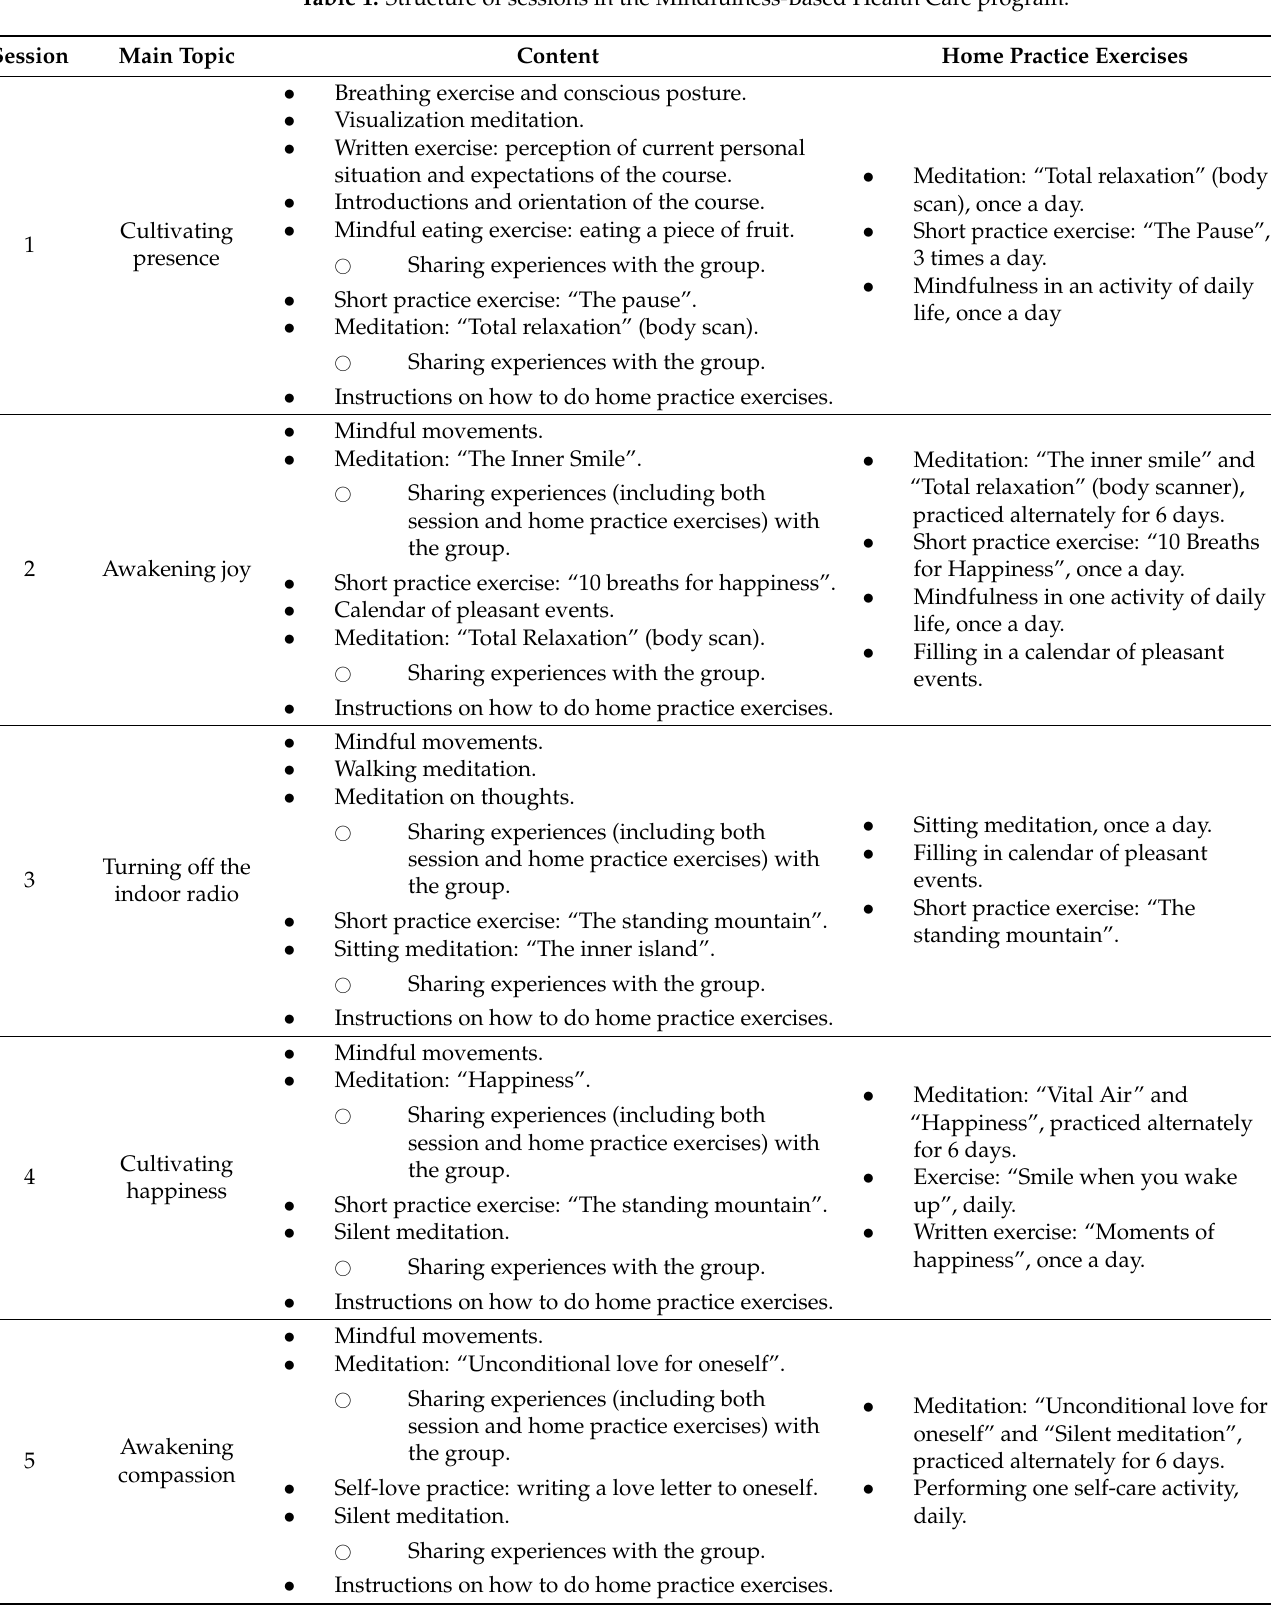
Table 1. Structure of sessions in the Mindfulness-Based Health Care